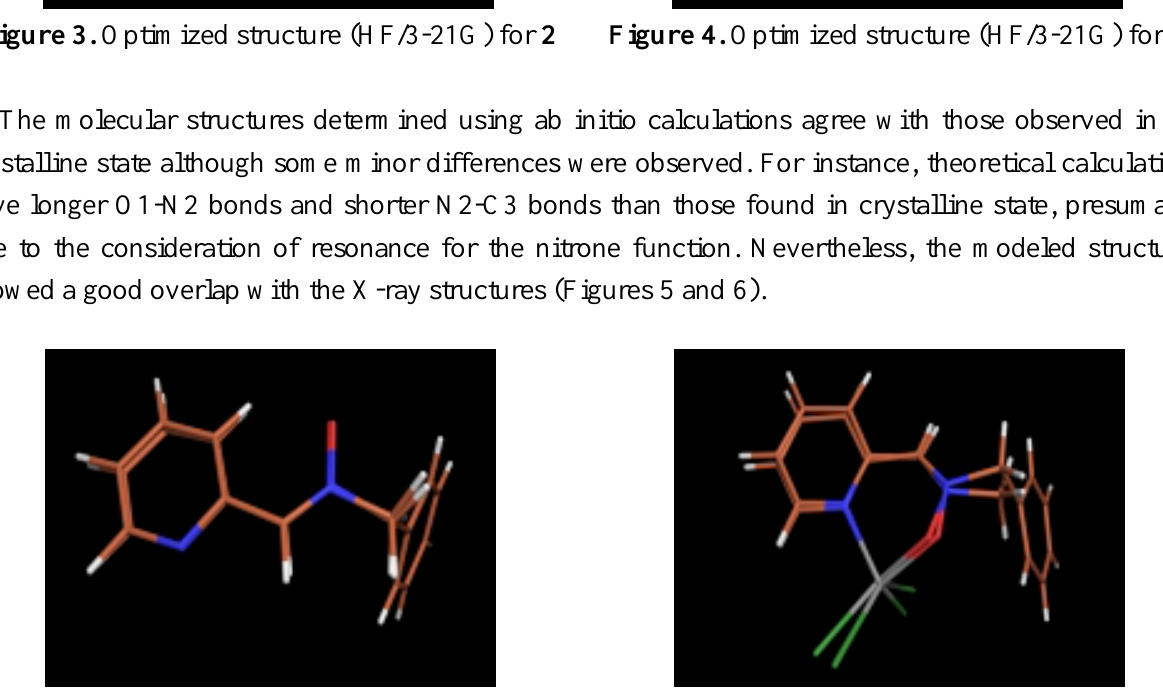
Figure 6. Comparison of the modeled structure of complex 6 with the X-ray